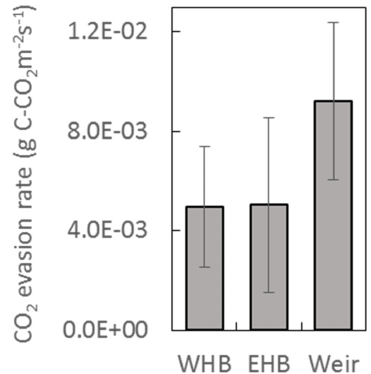
Figure 8. CO 2 evasion rate measured at two blocked drains on the high bog (WHB and EHB) and just upstream of the weir. Locations of WHB and EHB are shown as white dots in Fig. 1 as is the Weir location. Data were collected between March and July 2017 at the WHB location ( n = 7), November 2016 and July 2017 at the EHB location ( n = 8), and December 2016 and July 2017 at the weir lo- cation ( n =